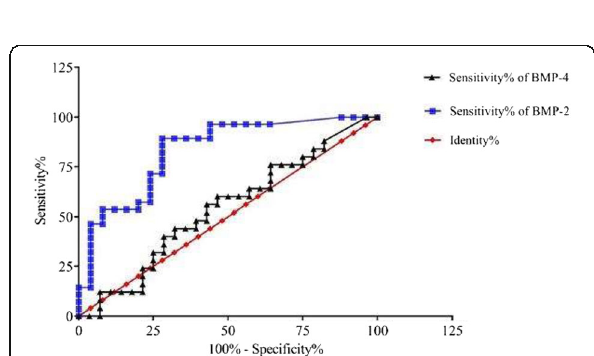
Fig. 3 (abstract 0122). ROC curves for BMP-2 and BMP-4 in separating sepsis from non-sepsis in